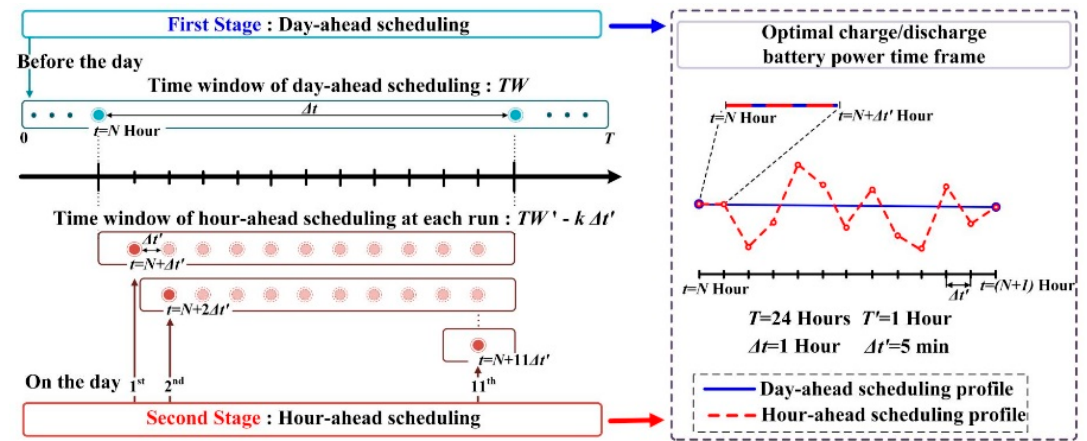
Figure 3. Time framework for the proposed two-stage scheduling.